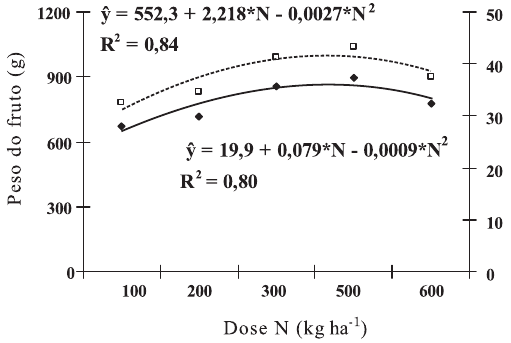
Figura 3. peso médio de infrutescências ( ) e produ- tividade ( ) de abacaxizeiro ‘Vitória’, em função das doses de N. * significativo a 5 % pelo teste